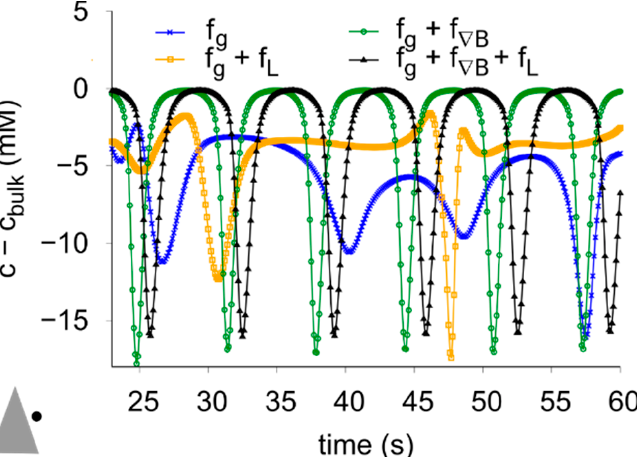
Figure 11. Concentration at point (0.77, 1.02) mm for the 8 mA/cm 2 case obtained from simulations where only selected volume forces are active. 𝑓 (cid:2917) : Only the buoyancy force. 𝑓 (cid:2917) + 𝑓 (cid:2896) : Buoyancy and Lorentz force. 𝑓 (cid:2917) + 𝑓 ∇(cid:2886) : Buoyancy and magnetic gradient force. 𝑓 (cid:2917) + 𝑓 (cid:2896) + 𝑓 ∇(cid:2886) : All three forces. Note that the concentration values are not averaged in the laser direction.